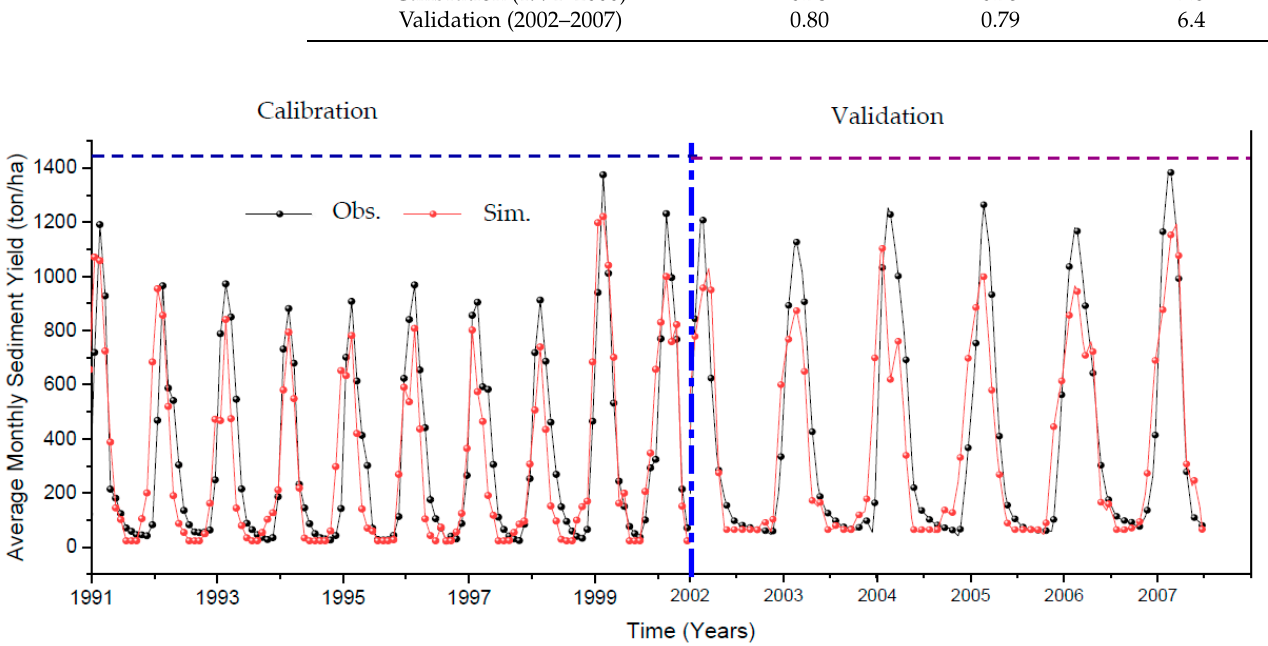
Figure 6. Monthly calibration (1991–2000) and validation (2002–2007) results of measured and simulated sediment yield.